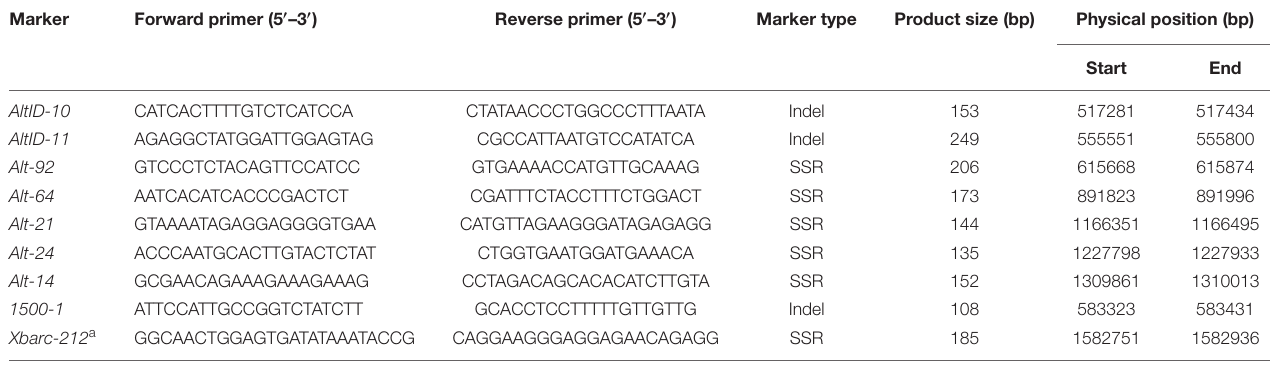
TABLE 2 | The primer sequences used in this study. Marker Forward primer (5 (cid:48) –3 (cid:48) ) Reverse primer (5 (cid:48) –3 (cid:48) ) Marker type Product size (bp)